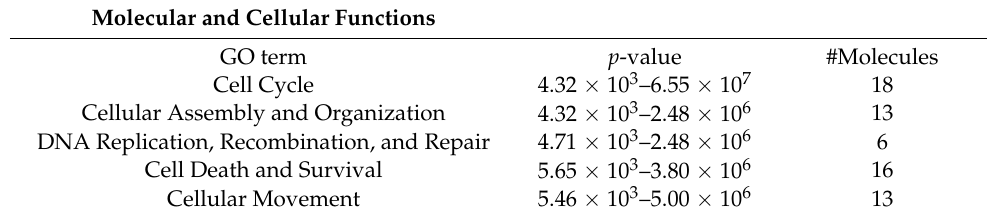
Table 3. Gene ontology analysis of extracted downregulated genes. Molecular and Cellular